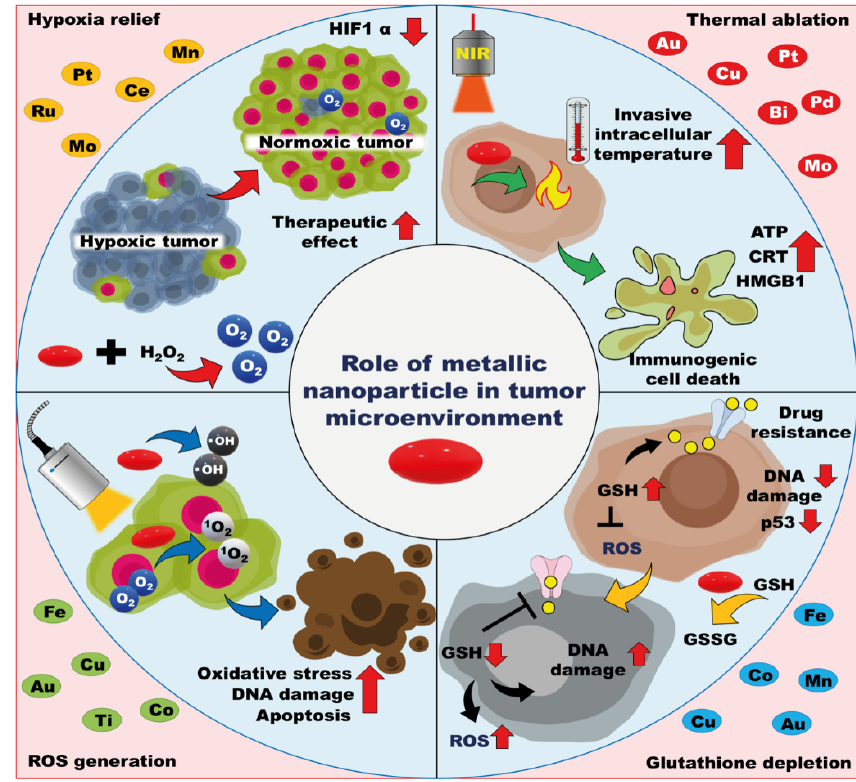
Figure 3. MNP-mediated TME modulation. MNPs alleviate tumor hypoxia by generating sufficient oxygen supply, thus promoting therapeutic activities. MNP-mediated GSH depletion inside cancer cells enhances the expression of excessive ROS and causes tumor cell death. Thermal ablation and ROS production increase temperature and induce oxidative stress, which leads to immunogenic cell death (ICD).